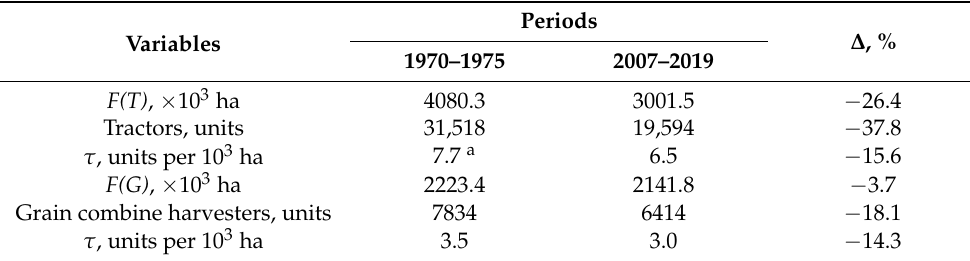
Table 5. Changes in the total number of tractors and grain combine harvesters in the Stavropol Krai (SW Russia) between 1970–1975 and 2007–2019. Variables